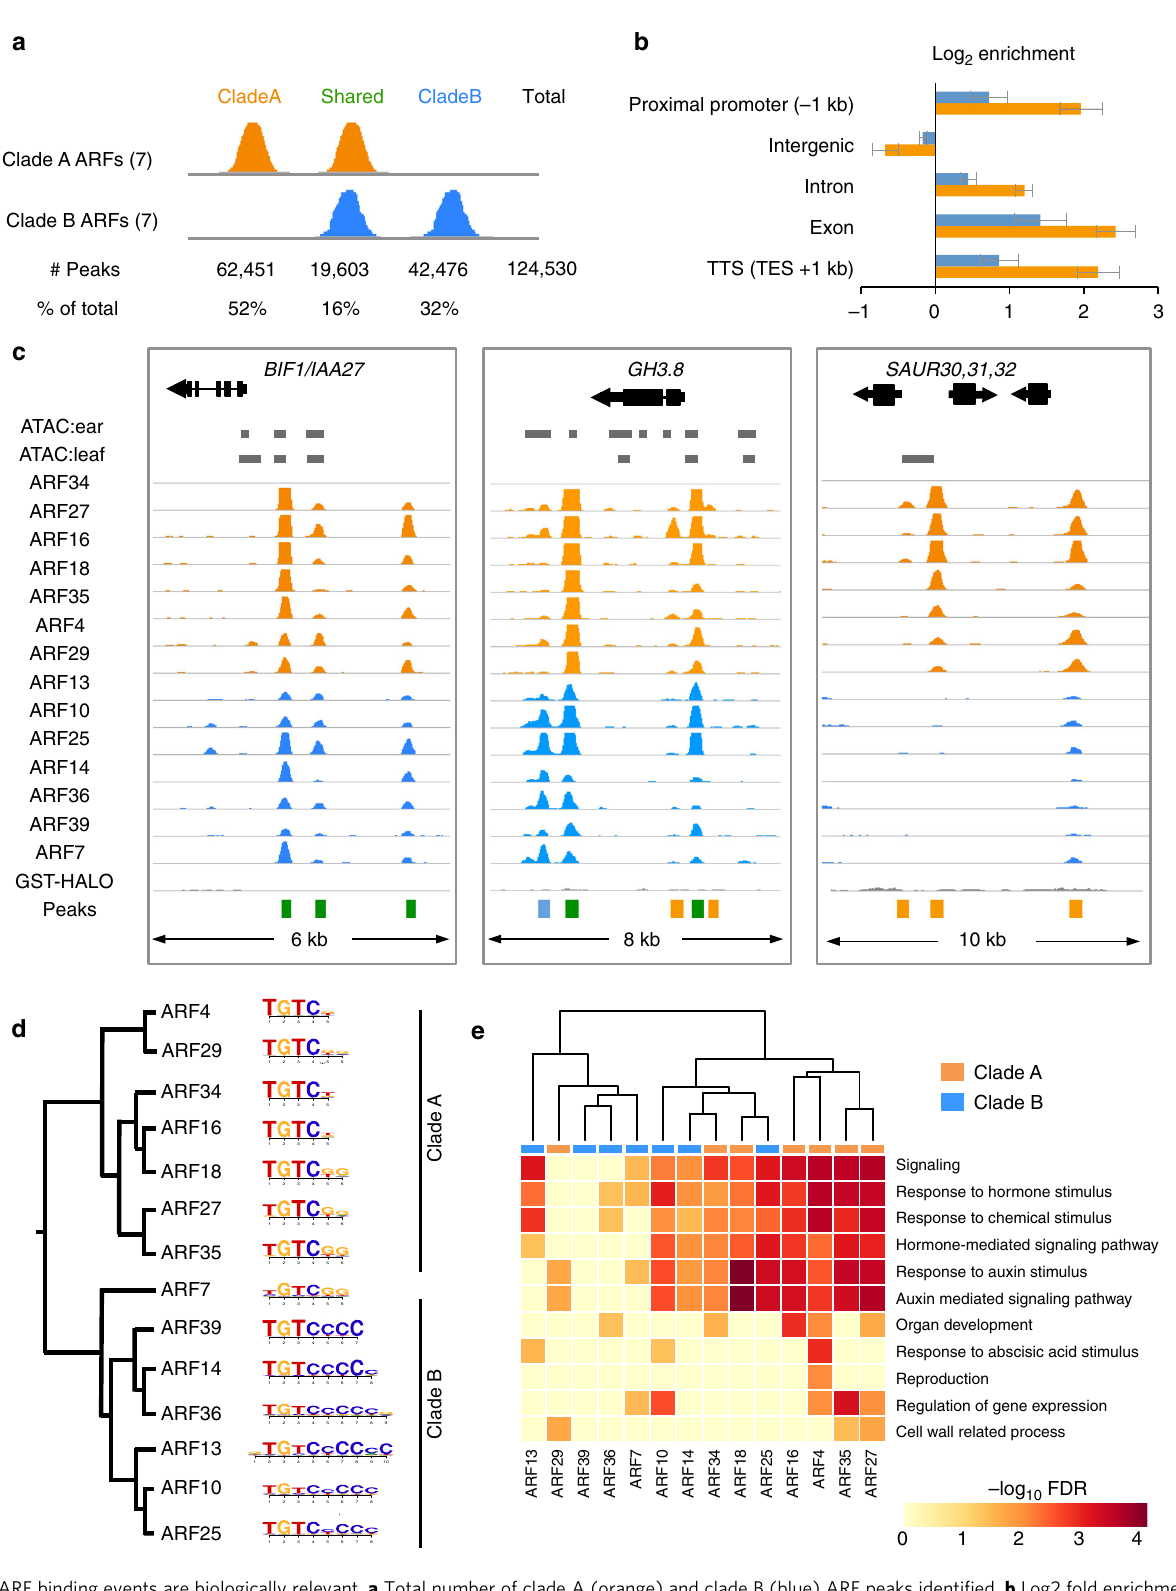
Fig. 1 ARF binding events are biologically relevant. a Total number of clade A (orange) and clade B (blue) ARF peaks identi fi ed. b Log2 fold enrichment of peaks relative to gene features. Error bars show standard deviation. c ARF peaks are located in putative regulatory regions of known auxin responsive genes. GST-HALO track indicates reads from negative control. Regions of accessible chromatin in immature ears and young leaves as determined by ATAC-seq are depicted as gray bars. Colored bars at bottom correspond to called peaks; orange, clade A ARF; blue, clade B ARF; green, peak called in both clade A and B datasets. d Top motif identi fi ed for each ARF. Dendrogram based on ARF amino acid sequence similarity. e Predicted ARF target genes are enriched for functional GO terms related to auxin and other